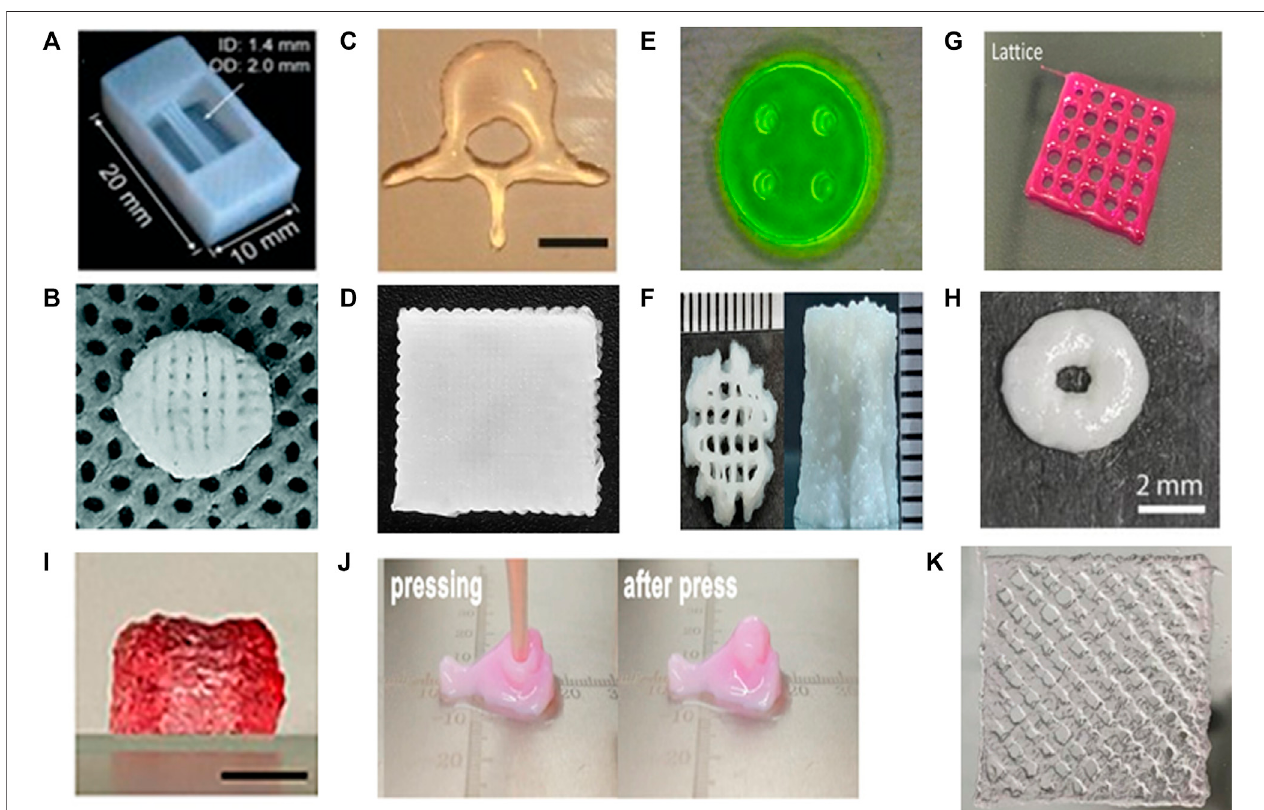
FIGURE 4 | Different ECM-based biomaterial types and resulted constructs. (A) Tube construct printed with collagen. Adapted with permission from (Lee et al., 2019). (B) Scaffoldprintedwithcollagen/heparinsulfate.Adapted withpermission from(Jiangetal.,2020). (C) Thenon-poroushumanL3vertebraeprintedwithMeHA. Adapted with permission from (Poldervaart et al., 2017). (D) The scaffolds printed with gelatin-alginate-hyaluronic acid. Adapted with permission from (Bertuola et al., 2021). (E) ThenerveguidanceconduitsprintedwithGelMA.Adaptedwithpermissionfrom(Yeetal.,2020). (F) ThescaffoldprintedwithgelMAandhydroxyapatite (DasandBasu,2022). (G) Thescaffoldprintedwithskin-deriveddECMbioink.Adaptedwithpermissionfrom(Kimetal.,2018). (H) Thescaffoldprintedwithliver-derived dECM/PCL bioink. Adapted with permission from (Elomaa et al., 2020). (I) The dual cross-linked constructs printed with oxidized hyaluronate (OHA)/glycol chitosan (GC)/adipic acid dihydrazide (ADH)/hyaluronate-alginate hybrid (HAH). The gel constructs maintained their original dimension after 3weeks at 37 ° . Adapted with permissionfrom(Kimetal.,2022). (J) Nose-shapedconstructprintedwithPU-gelatin.Adaptedwithpermissionfrom(HsiehandHsu,2019).Copyright(2019)American Chemical Society. (K) The scaffold printed with tetrameric peptides as bioinks. Adapted with permission from (Rauf et al.,